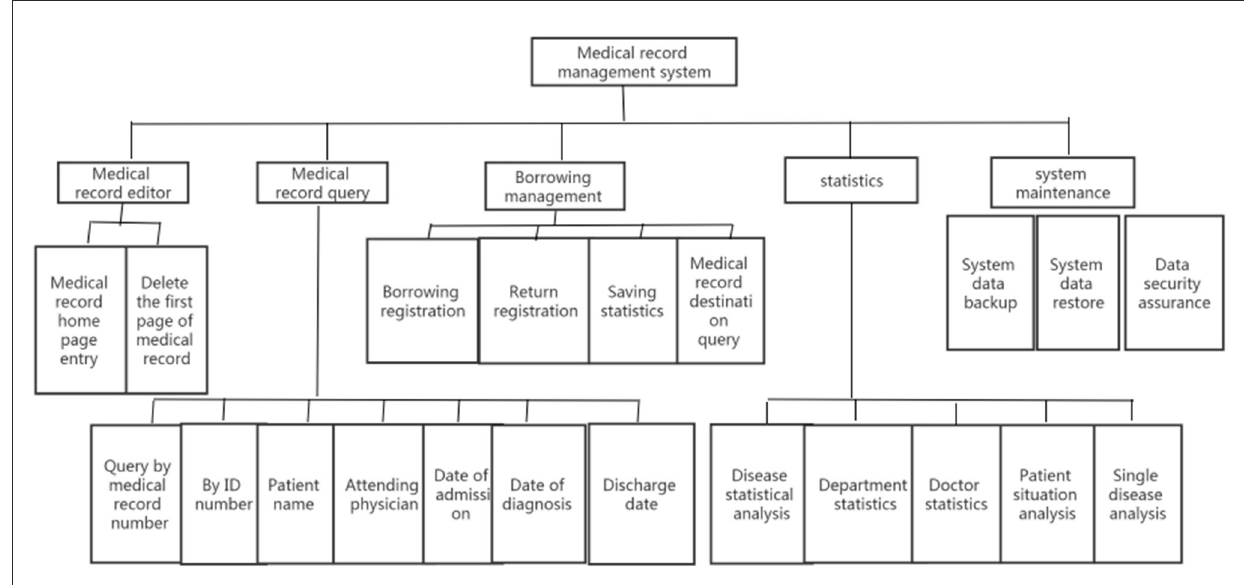
FIGURE1 Flow chart of medical record management for patients with cerebral